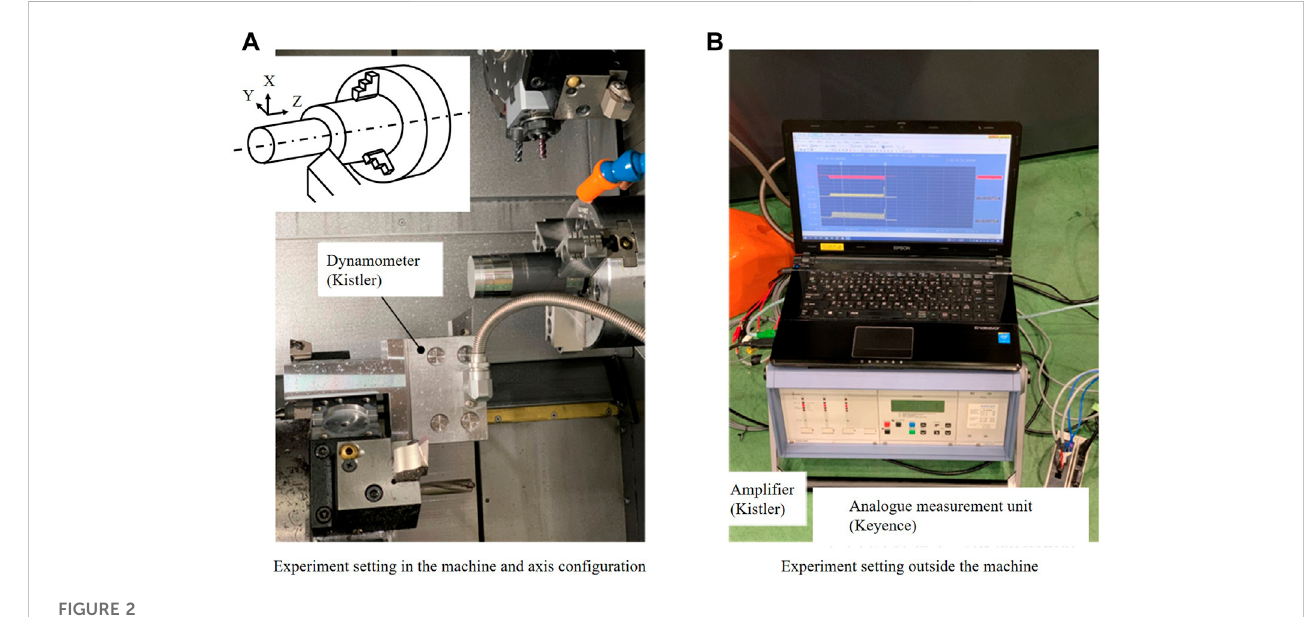
FIGURE 2 Con fi guration of experimental system.